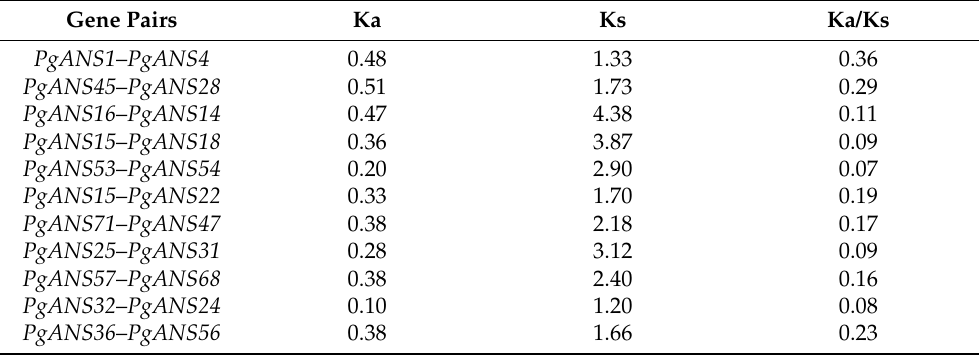
Table 3. Estimated divergence period of the PgANS gene pairs. Ks, synonymous substitution rate; Ka, non-synonymous substitution